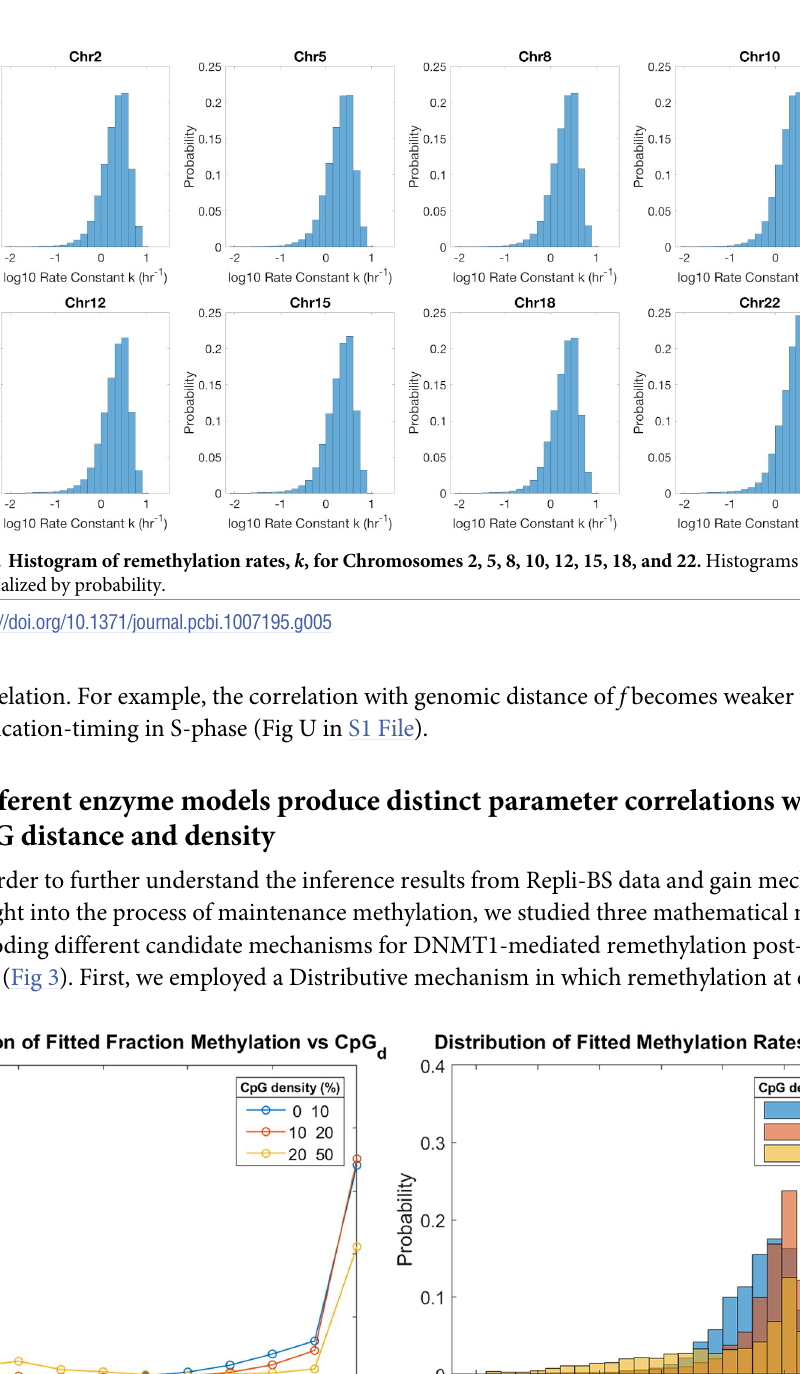
]%, where CpG is the maximum CpG found in Chr1 d d max d max